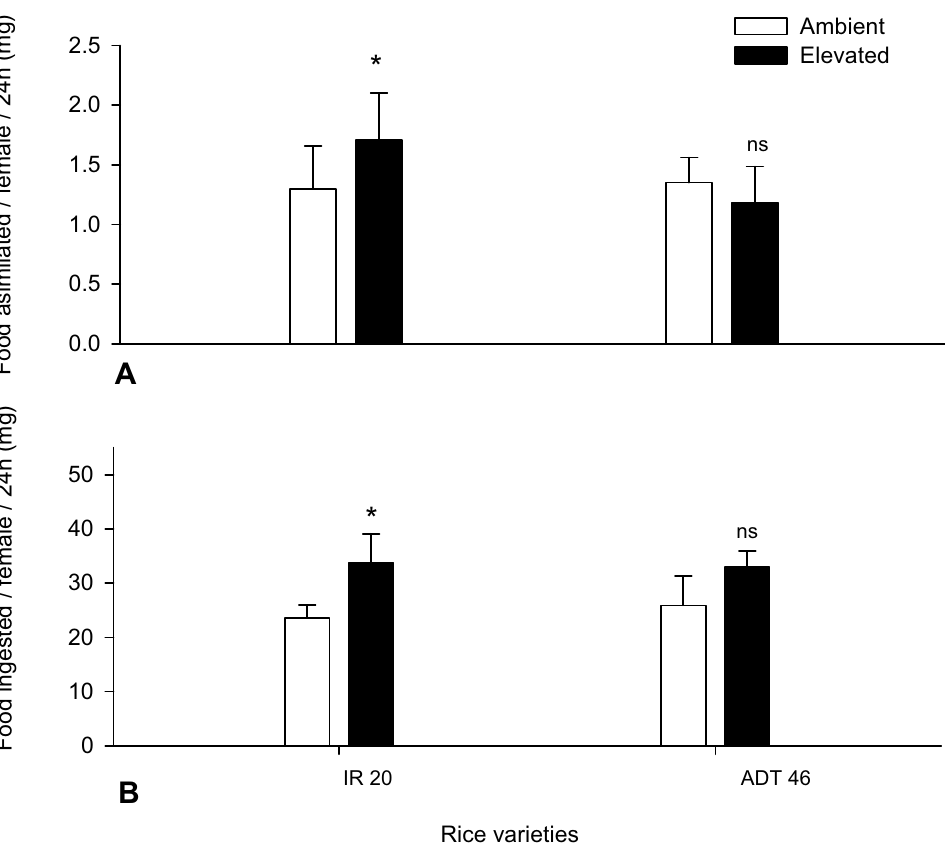
Figure 7. Food utilization of N. lugens under e CO 2 (Mean (± SEM) followed by the symbol * in an individual experiment indicate significant difference (P < 0.05) in a Tukeys test) (ns-non